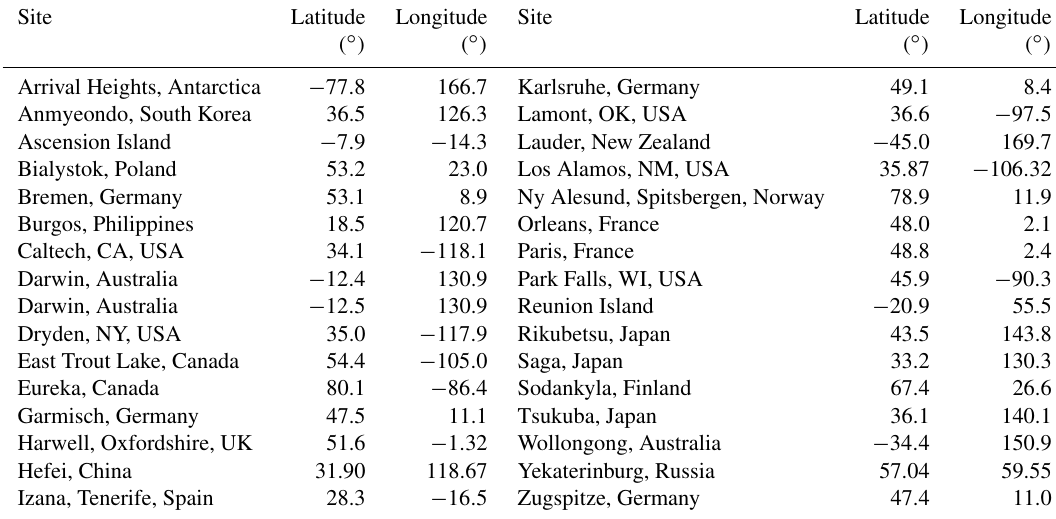
Table 3. TCCON stations used in this OSSE